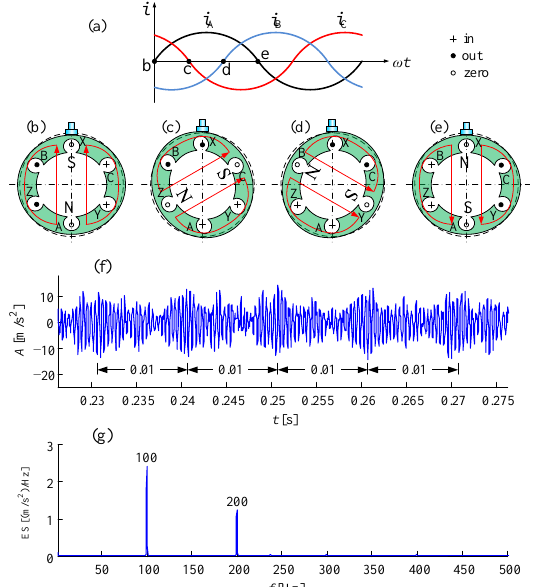
Figure 28. Electromagnetic vibration of generator stator: ( a ) three phase alternating currents; ( b ) deformation at time b; ( c ) deformation at time c; ( d ) deformation at time d; ( e ) deformation at time e; ( f ) modulated vibration signal; ( g ) demodulated electromagnetic vibration.